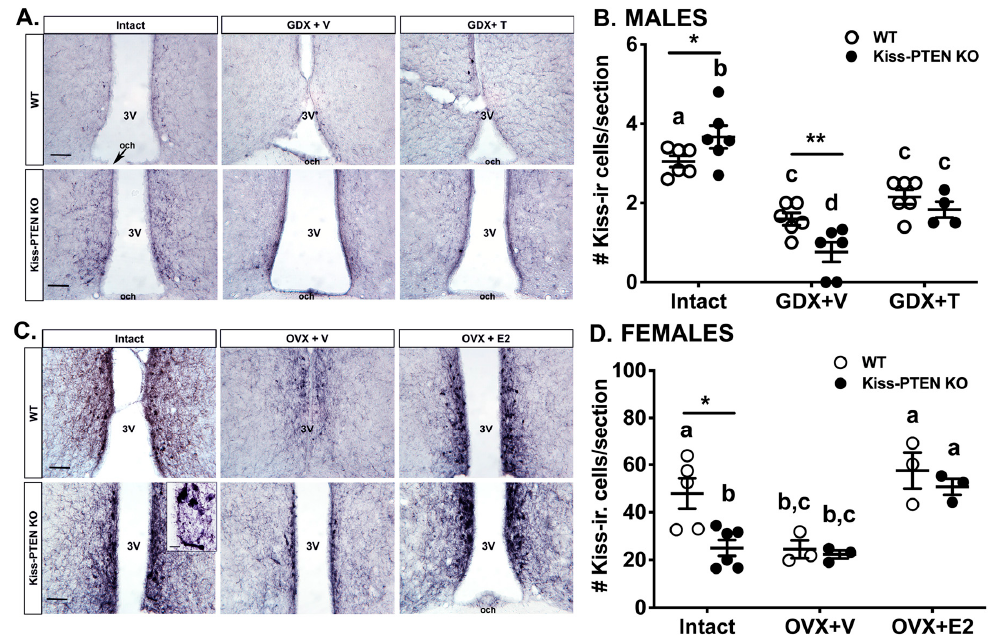
Figure 3. Altered kisspeptin neuron-immunoreactivity (ir) in the AVPV of Kiss-PTEN KO mice. ( A ) Representative images of immunostaining against kisspeptin in the AVPV of gonad-intact, or gonadectomized adult WT and Kiss-PTEN KO males treated with vehicle (GDX+V) or with T-containing capsules (GDX+T) for 10 days. Scale bar = 100 μ m. 3V, third ventricle, och, optic chiasm. ( B ) Quantification of kisspeptin-ir cells from each group in ( A ). Values are means ± SEM, (n = 4–6/treatment/genotype). Different letters denote significant differences (two-way ANOVA, Holm Šidák post-hoc). p < 0.05, ** p < 0.01, denotes significant differences between genotypes. ( C ) Representative images of AVPV kisspeptin-ir from gonad-intact, or OVX adult WT and Kiss-PTEN KO females treated with vehicle (OVX+V) or with E 2 -containing capsules (OVX+E2) for 10 days. Scale bar = 100 μ m. 3V, third ventricle, och, optic chiasm. ( D ) Quantification of kisspeptin-ir cells from each group in ( C ). Values are means ± SEM (n = 3–6/treatment/genotype). Different letters denote significant differences (two-way ANOVA, Holm Šidák post-hoc). * p < 0.05, denotes significant differences between genotypes.